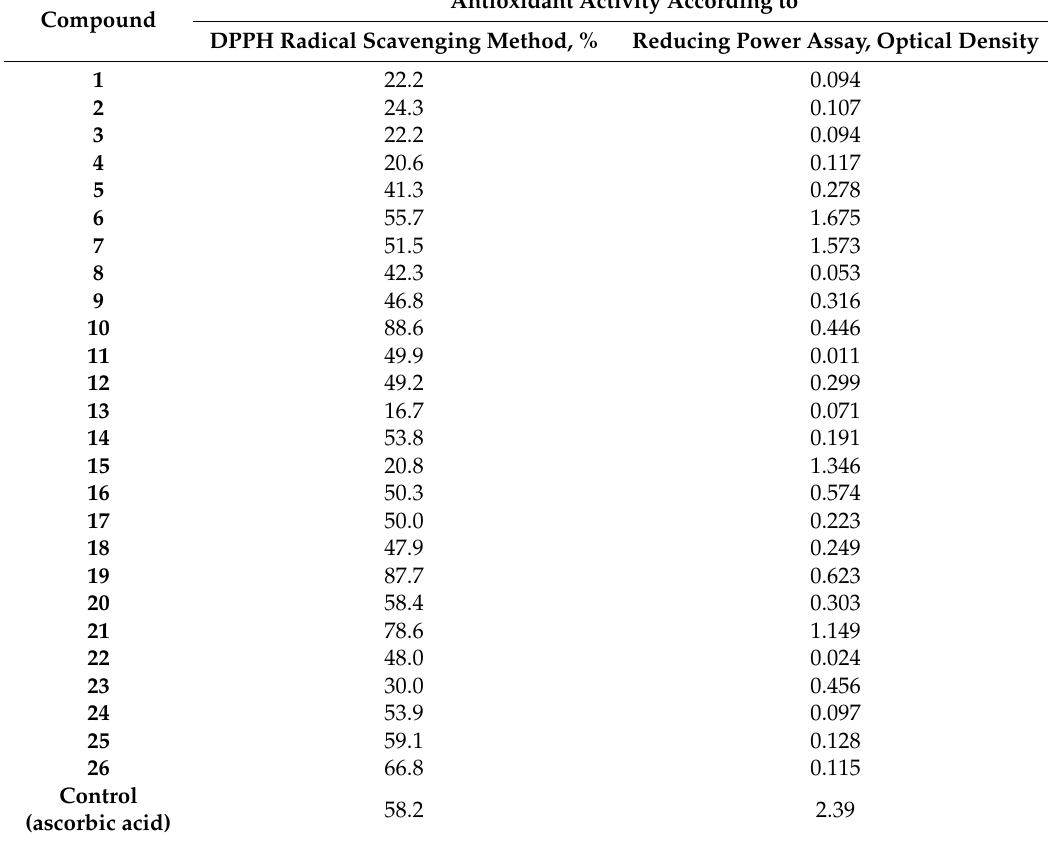
Table 1. Antioxidant activity of compounds 1 – 26 evaluated by DPPH radical scavenging method and reducing power assay.